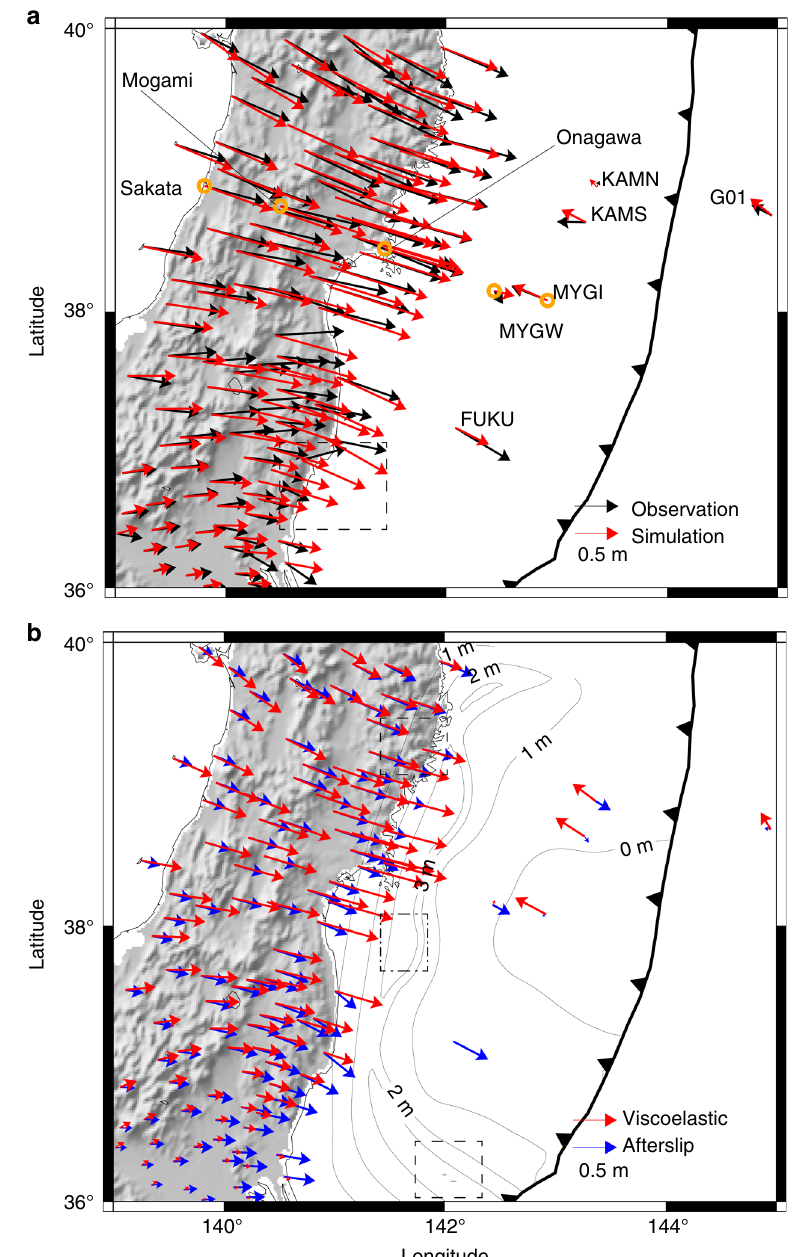
Fig. 4 Post-earthquake deformation of the 2011 Tohoku-Oki earthquake. a The horizontal component of 2.8-year post-earthquake displacements. In the station G01, the contribution from the plate convergence rate (shown in Fig. 1a), which is not included in our simulation scheme, is added to the simulation result (see Methods). In addition, displacement in the period 1.5 years and 2.8 years after the earthquake is plotted in this station because of the limitation of data availability. Displacement time series in the stations marked by orange circles are shown in Fig. 6. b The horizontal components of 2.8-year post- earthquake displacements in the simulation broken down into the contribution from elastic deformation due to afterslip and viscoelastic fl ow. The viscoelastic component includes the contribution from both coseismic slip and afterslip. The contour lines indicate accumulated afterslip for 2.8 years. The fi t to the horizontal displacements in the station FUKU would be better if large afterslip in the dashed rectangle were slightly closer to